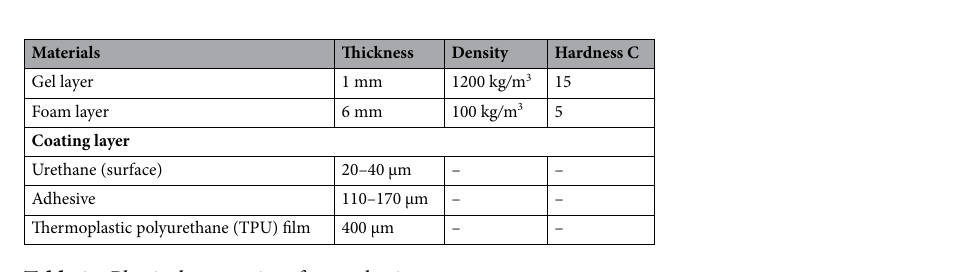
Table 2. Physical properties of our robotic